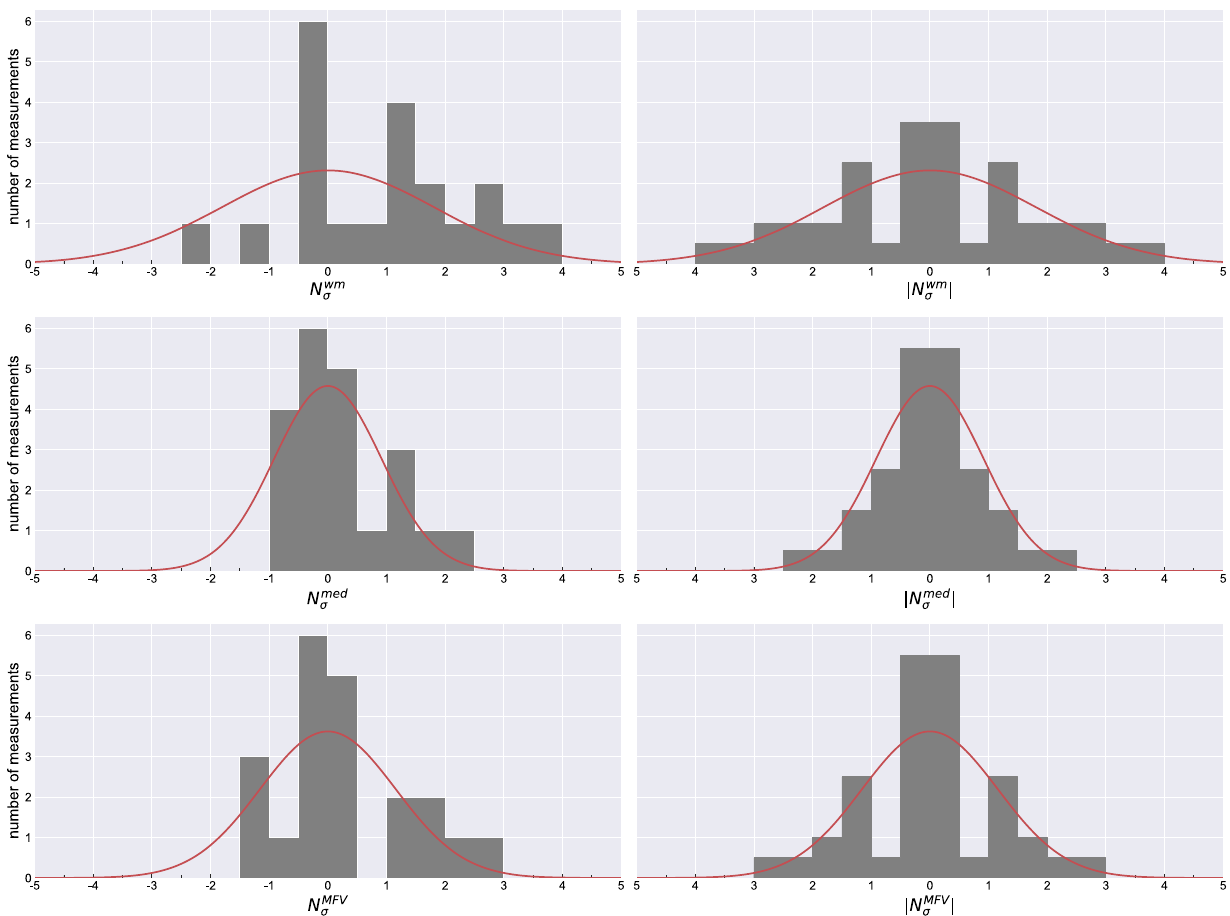
Fig. 6 Histograms of the number of standard deviations in half bins away from the weighted mean, median, and MFV listed in the top, middle, and bottom rows. The left (right) column illustrates the signed